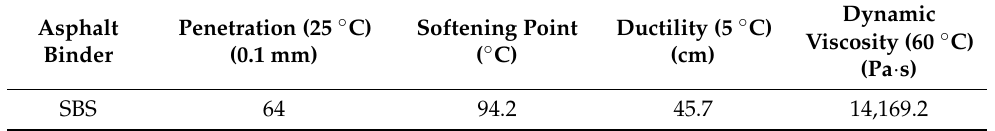
Table 2. Properties of SBS modified asphalt